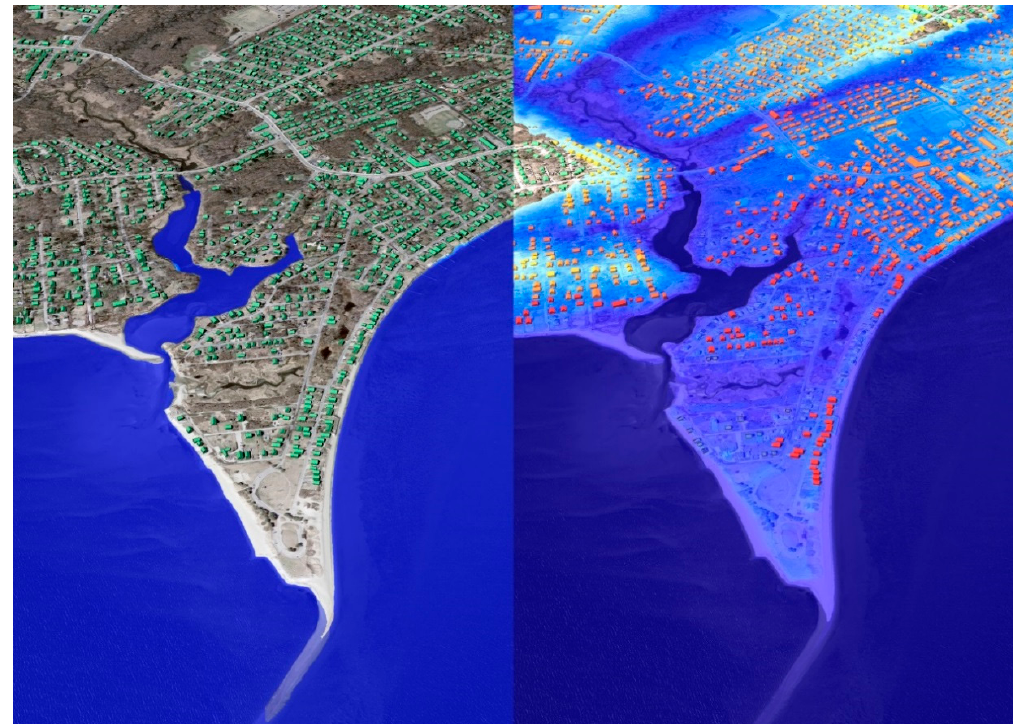
Figure 3. Cropped comparison of Warwick, RI, USA, as used on the front page of the Providence Journal newspaper juxtaposing the no inundation scenario with a scenario depicting 7' of sea level rise and a storm event with a 1% chance of occurrence [6,39]. The comparison and cropping of the image emphasizes the already extreme scenario. Image: Authors.